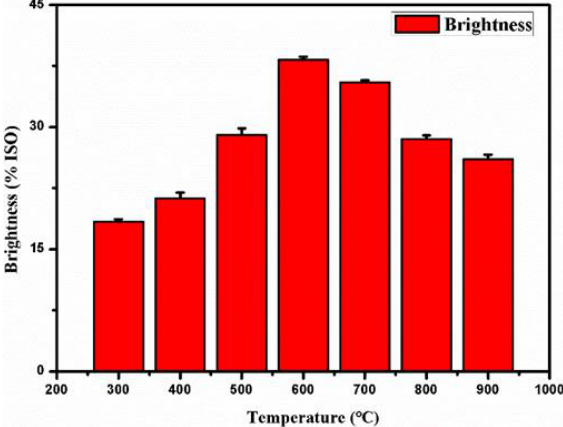
Figure 3. Relationship between brightness and heating temperature of fly ash.